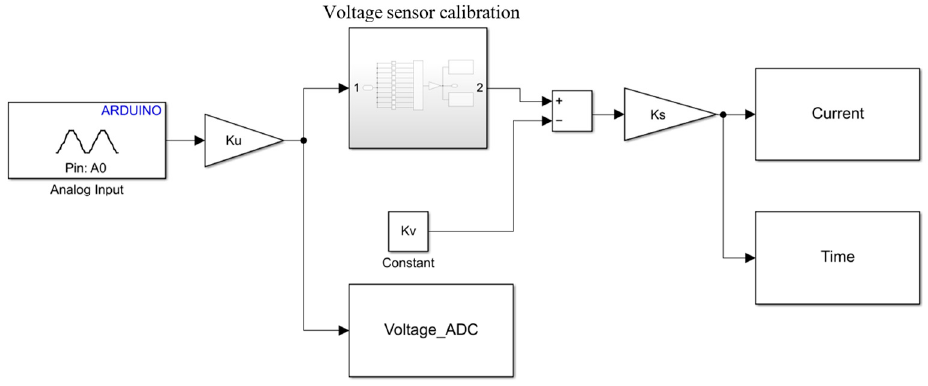
Figure 14. Simulink model for current monitoring.